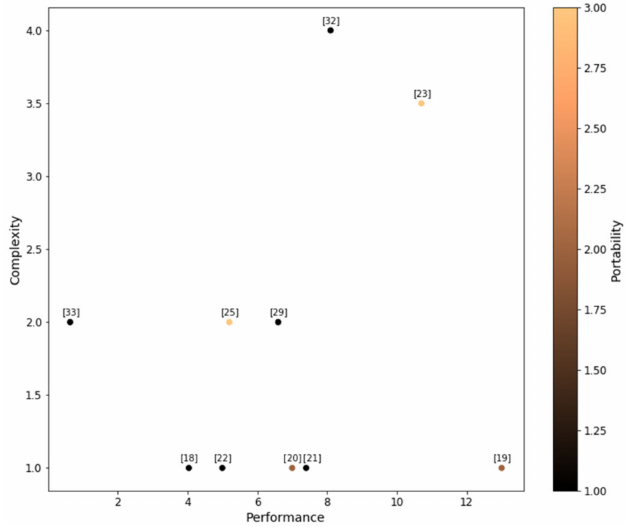
Figure 3. Comparing the identified systems in performance, complexity, and portability. Complexity score is determined based on the number of sensors used in the system. The error is calculated as RMSE or accuracy ± precision and the portability is determined by using a scoring system proposed by the authors. The numbers in square brackets refer to paper citations for the corresponding